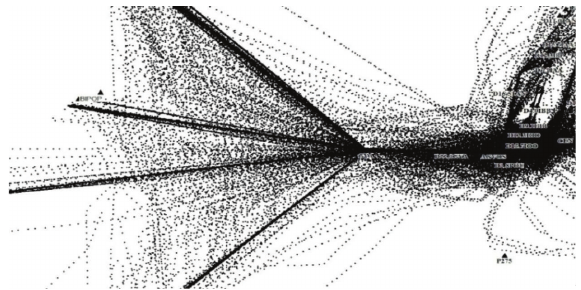
Figure 1: Radar track plot in airport terminal area (source: ZGGG